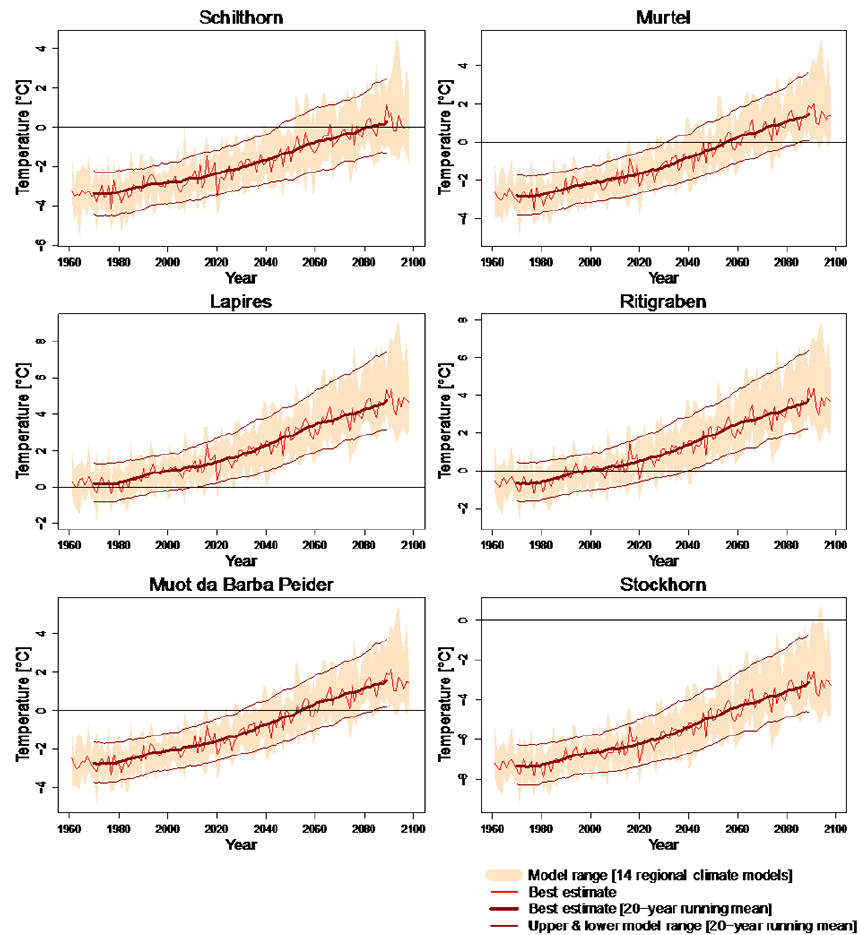
Figure 2. Site-scale climate scenarios of mean annual air temperature at 2m above ground (MAAT) for the six considered permafrost monitoring sites. The results are based on the developed scenarios using the two-step procedure (Fig. 1) and are based on 14 ENSEMBLES regional climate models assuming an A1B greenhouse gas emission